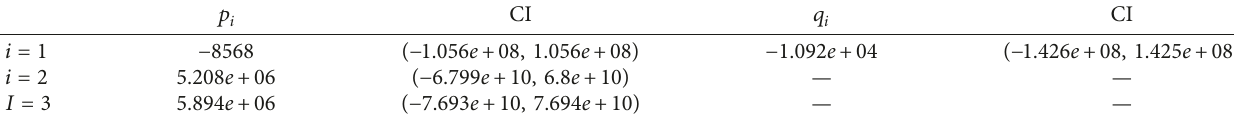
Table 15: F vs. HoF.